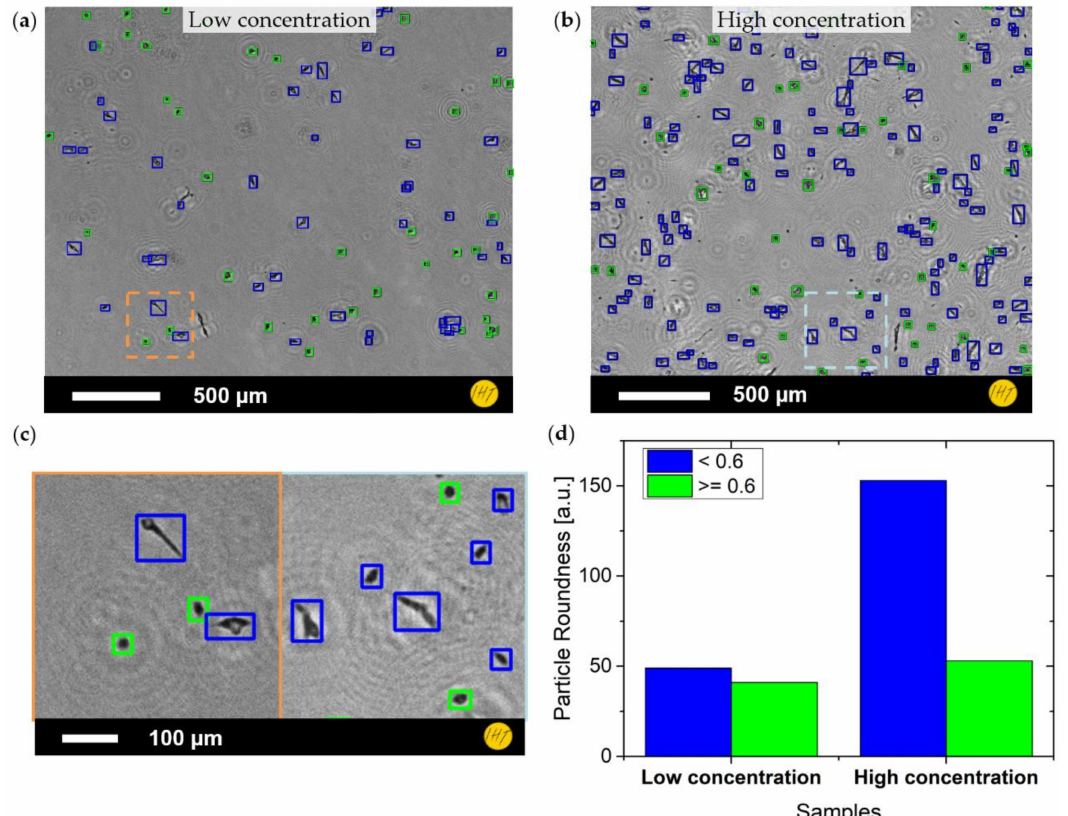
Figure 5. Cell registration of neuroblastoma cultures: ( a ) amplitude image of low concentration cell culture with cell findings overlay (blue for low roundness, green for high roundness); ( b ) amplitude image of high concentration cell culture with cell findings overlay (colors as in ( a )); ( c ) zoomed-in images (orange and light blue square) showing the distinction between the two cell types; and ( d ) histogram of counts shown in ( a , b ) (matching colors).